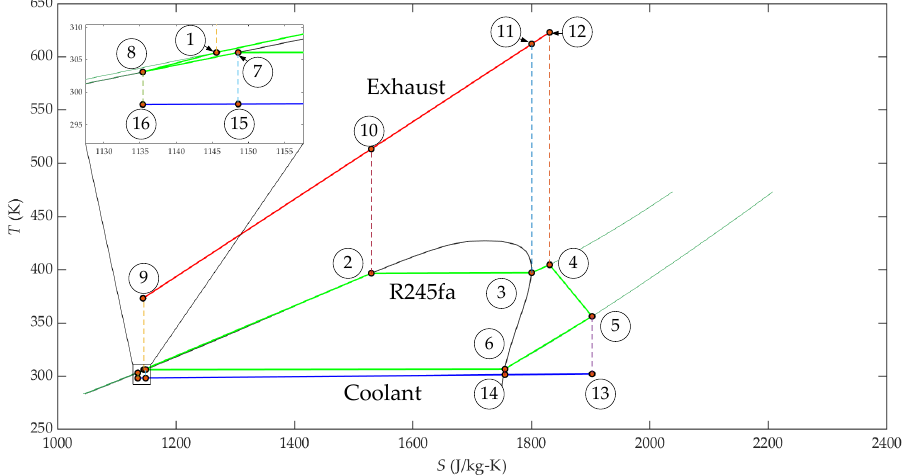
Figure 4. The T-S diagram with the state points.